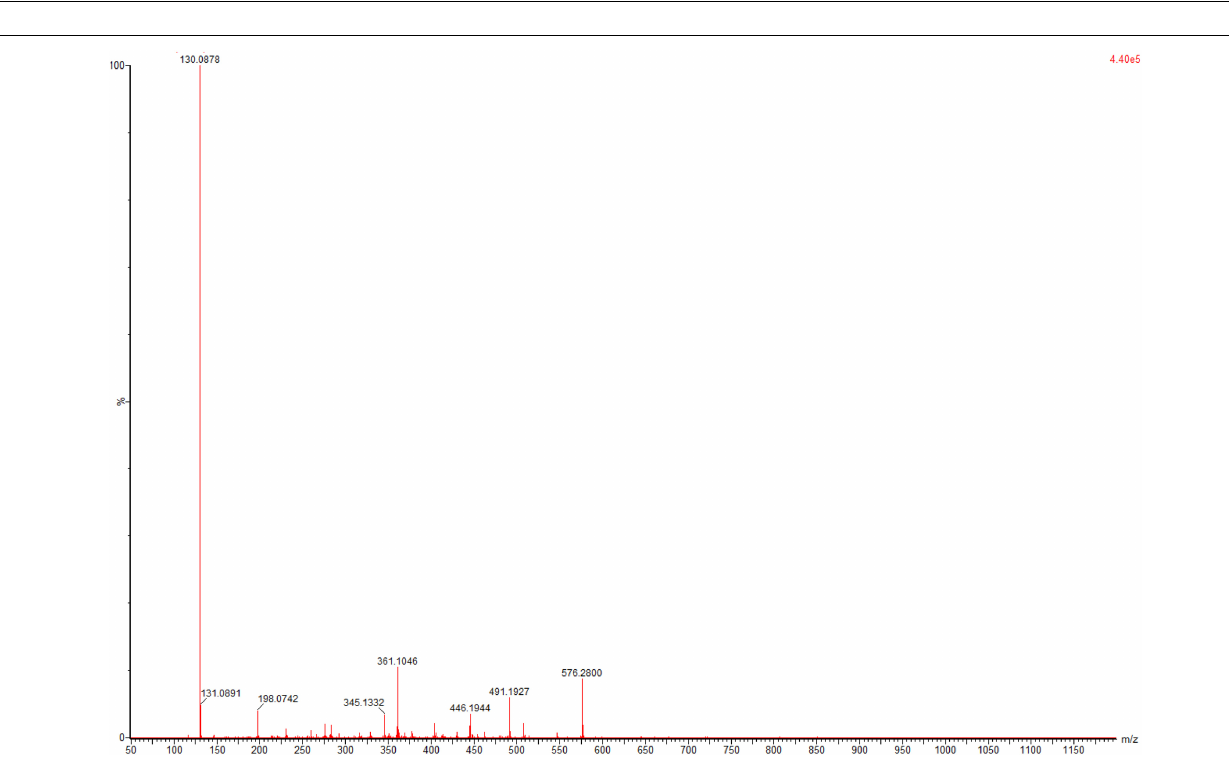
FIGURE 8 | The UPLC-MS analysis of target products in catalytic